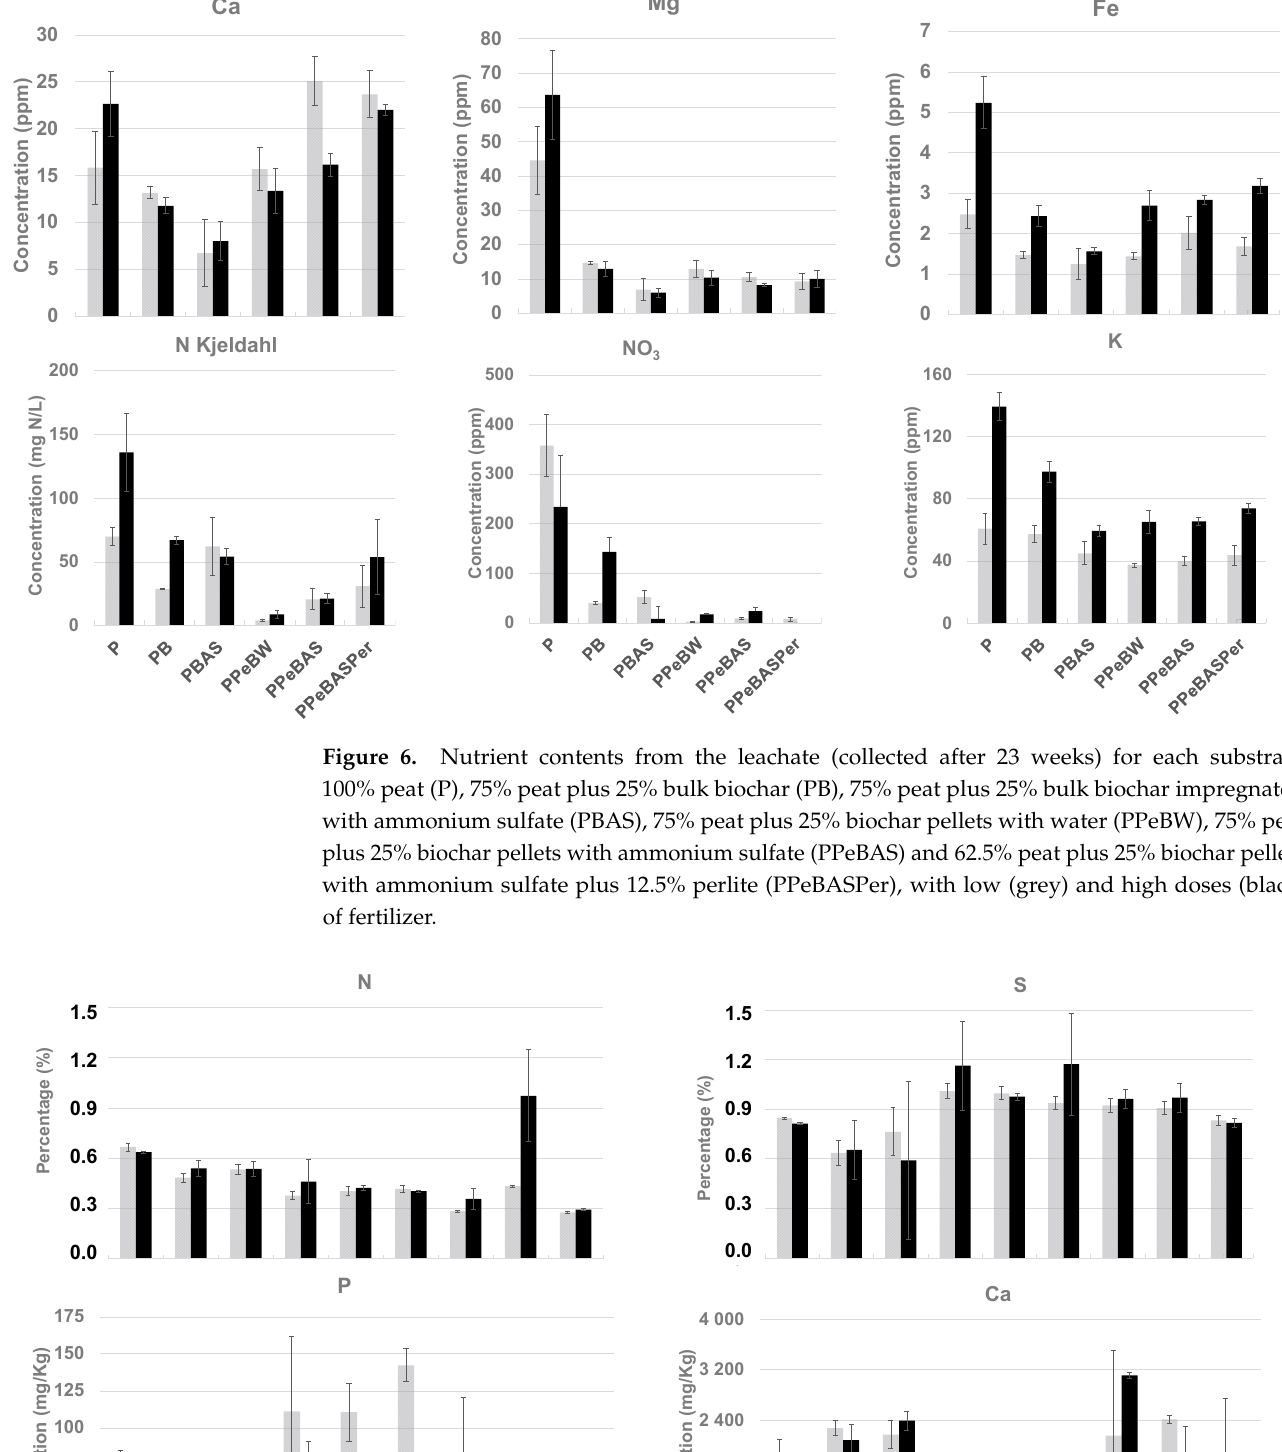
10 Figure 5. Dry biomass of spruce seedlings (collected after 23 weeks) growing on the different types of substrates: 100% peat (P), 75% peat plus 25% bulk biochar (PB), 75% peat plus 25% bulk biochar impregnated with ammonium sulfate (PBAS), 75% peat plus 25% biochar pellets with water (PPeBW), 75% peat plus 25% biochar pellets with ammonium sulfate (PPeBAS) and 62.5% peat plus 25% biochar pellets with ammonium sulfate plus 12.5% perlite (PPeBASPer), with low (half) and high doses (full) of fertilizer. Figures 6 and 7 show the most relevant nutrient contents from the leachate, from substrates and from pellets analyzed separately. Compared to the control (P), all treat- ments with biochar, whether in granular form or not, have reduced nutrient concentra- tions in the leachate, with the exception of calcium, which is relatively high in the leachate of the pellet treatments. A study on the use of the same kind of biochar for the removal of copper from a mining effluent showed that when several metals are present in water, a multi-metal competition during the adsorption process is observed [38]. This is probably caused by positively charged Ca being more attracted by the negative surface of the bio- char compared to the other metals. Thus, Ca might be released slowly from the pellet substrate over time. This is supported by the fact that there is more Ca in needles for the treatment with pellets (Figure 8). As to nutrients coming from the substrates, it is interesting to note that nitrogen is still present in the composition of the pellet only PPeBAS_Pe (Figure 7). Additionally, the substrates composed of pellets and peat showed a higher percentage of phosphorous (low dose), sulfur and calcium (high dose) compared to the control (P). On the other hand, the